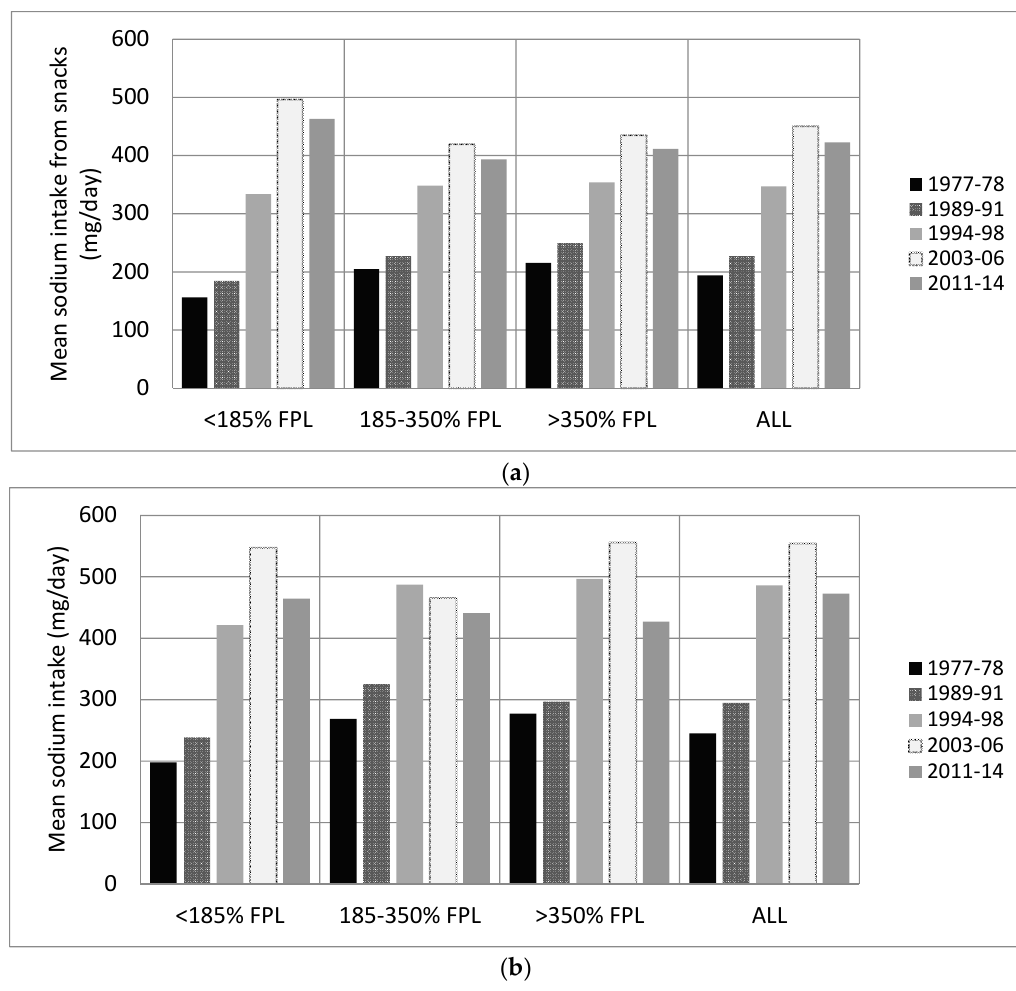
Figure 2. Sodium intake from snack food sources overall by income group in US adults and children ( a ) Adults; ( b ) Children. FPL, Federal Poverty Level.